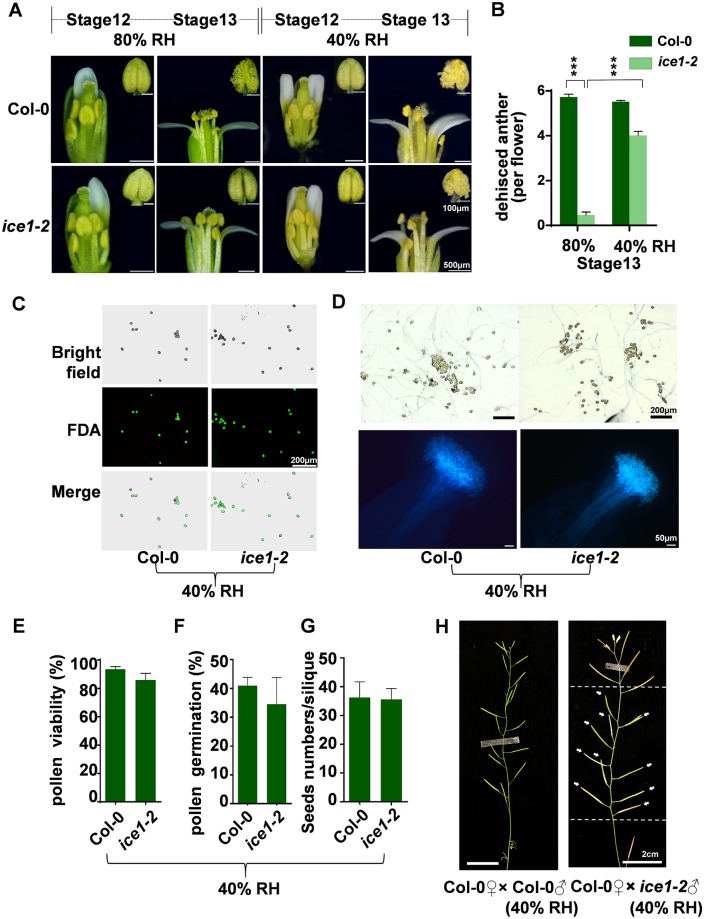
The pollen inviability, low pollen germination rate and anther indehiscence in ice1-2 can be rescued when grown in low humidity.(A) Flowers and anthers from Col-0 and ice1-2 plants grown under 40% or 80% relative humidity (RH), respectively. The insets (top left corner) exhibit magnification of anther phenotypes. (B) Comparison of dehisced anther numbers between Col-0 and ice1-2 per flower at flower stage 13 under 40% and 80% RH, respectively. (SE, n = 25–292 flowers, *** p < 0.001). (C) FDA (fluorescein diacetate) staining of pollen from Col-0 and ice1-2 at stage 13 under 40% RH. (D) The in vitro germination of pollen from Col-0 and ice1-2 at stage 13 under 40% RH (upper row). The aniline blue-stained pistils of Col-0 flowers at 2 h after pollination with pollen from Col-0 and ice1-2 at stage 13 under 40% RH are also shown (lower row). (E-G) Comparison of pollen viability (E) (SE, n = 5), pollen germination rates (F) (SE, n = 3), and seed numbers per silique (G) (SE, n = 20) between Col-0 and ice1-2 grown under 40% RH. (H) Manual pollination on the Col-0 plants grown in the normal condition with pollen from Col-0 and ice1-2 under 40% RH, respectively. Arrows indicate the normal siliques generated using ice1-2 pollen under 40% RH.